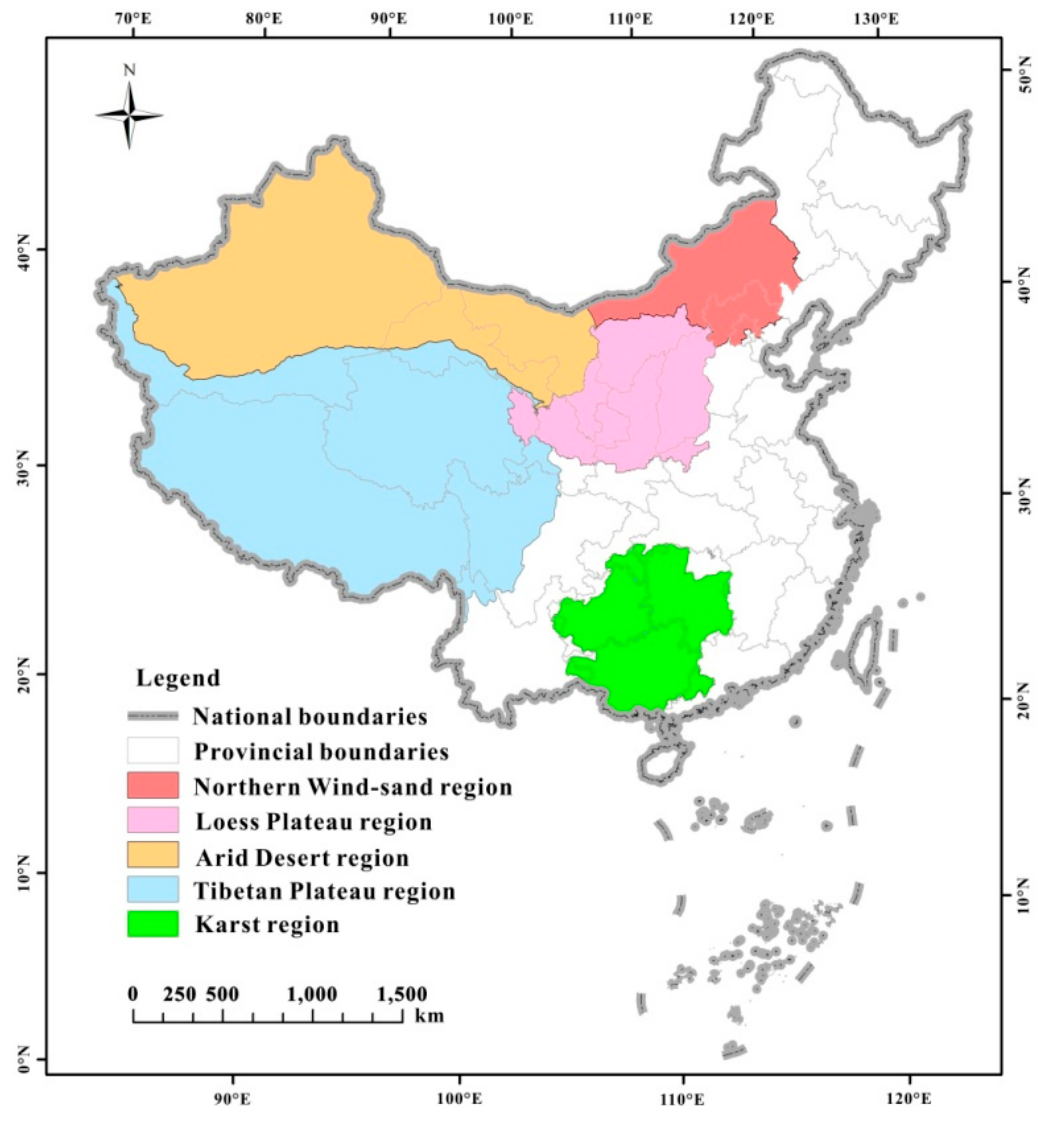
Figure 1. Location of the ecologically vulnerable regions.